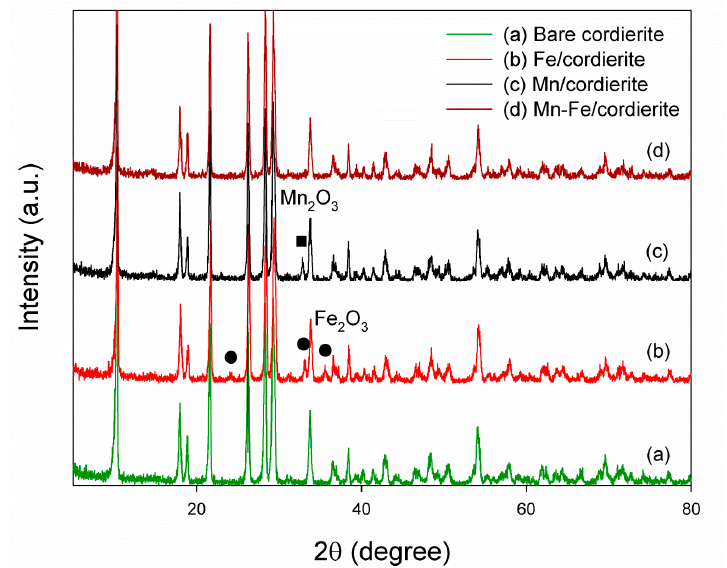
Figure 1. Powder XRD patterns of bare and coated